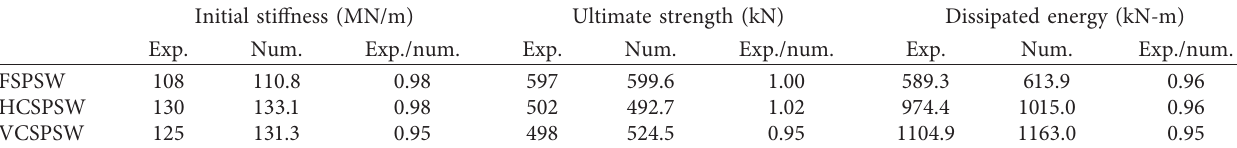
Table 2: Comparison between experimental and analytical results for initial stiffness, ultimate strength, and dissipated energy.